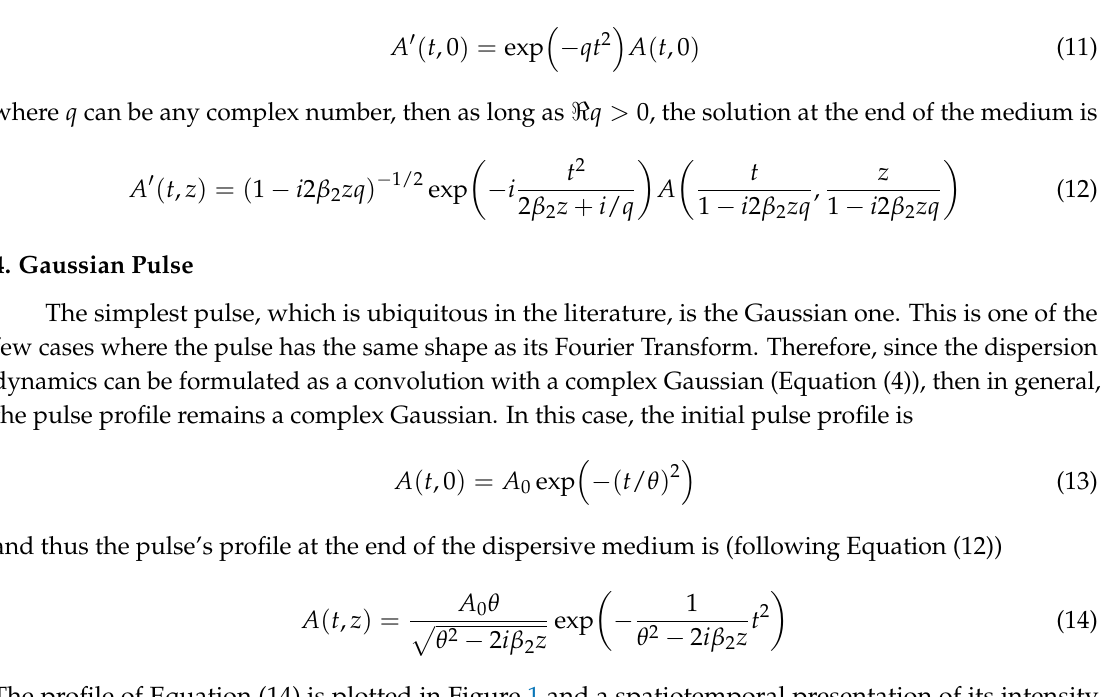
 z ), while the solid curve 2  z . Time is measured in 2